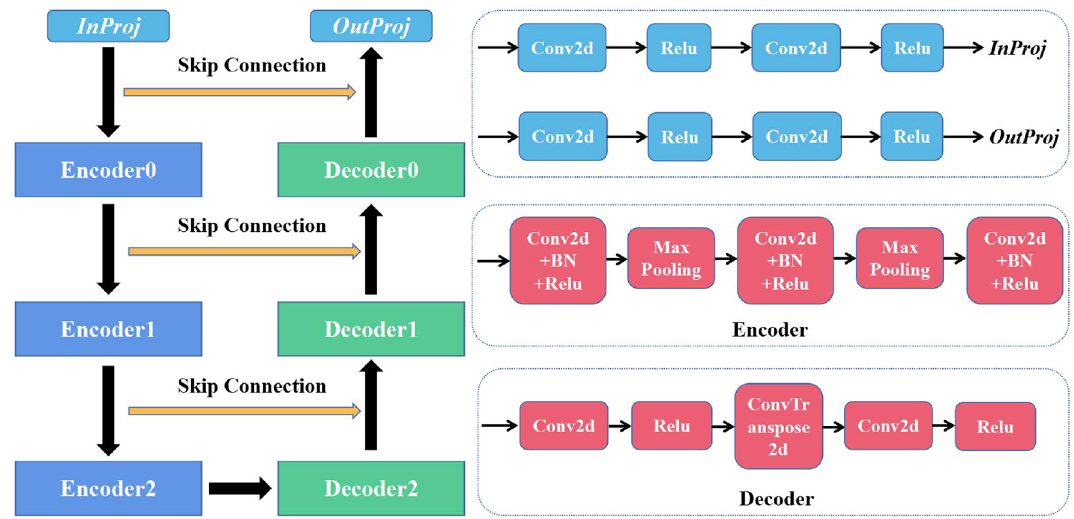
Figure 2. Architecture of DL based automatic segmentation